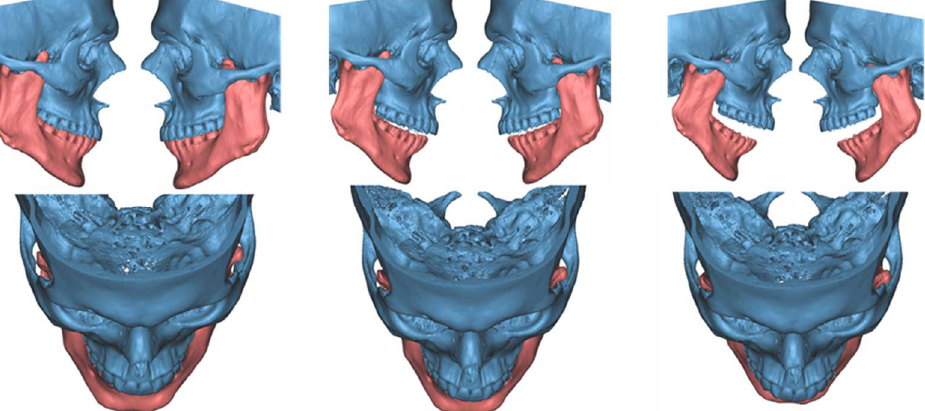
Figure 11. 3-dimensional dynamic reconstruction showing the bilateral pseudojoint determining a bilateral JD.